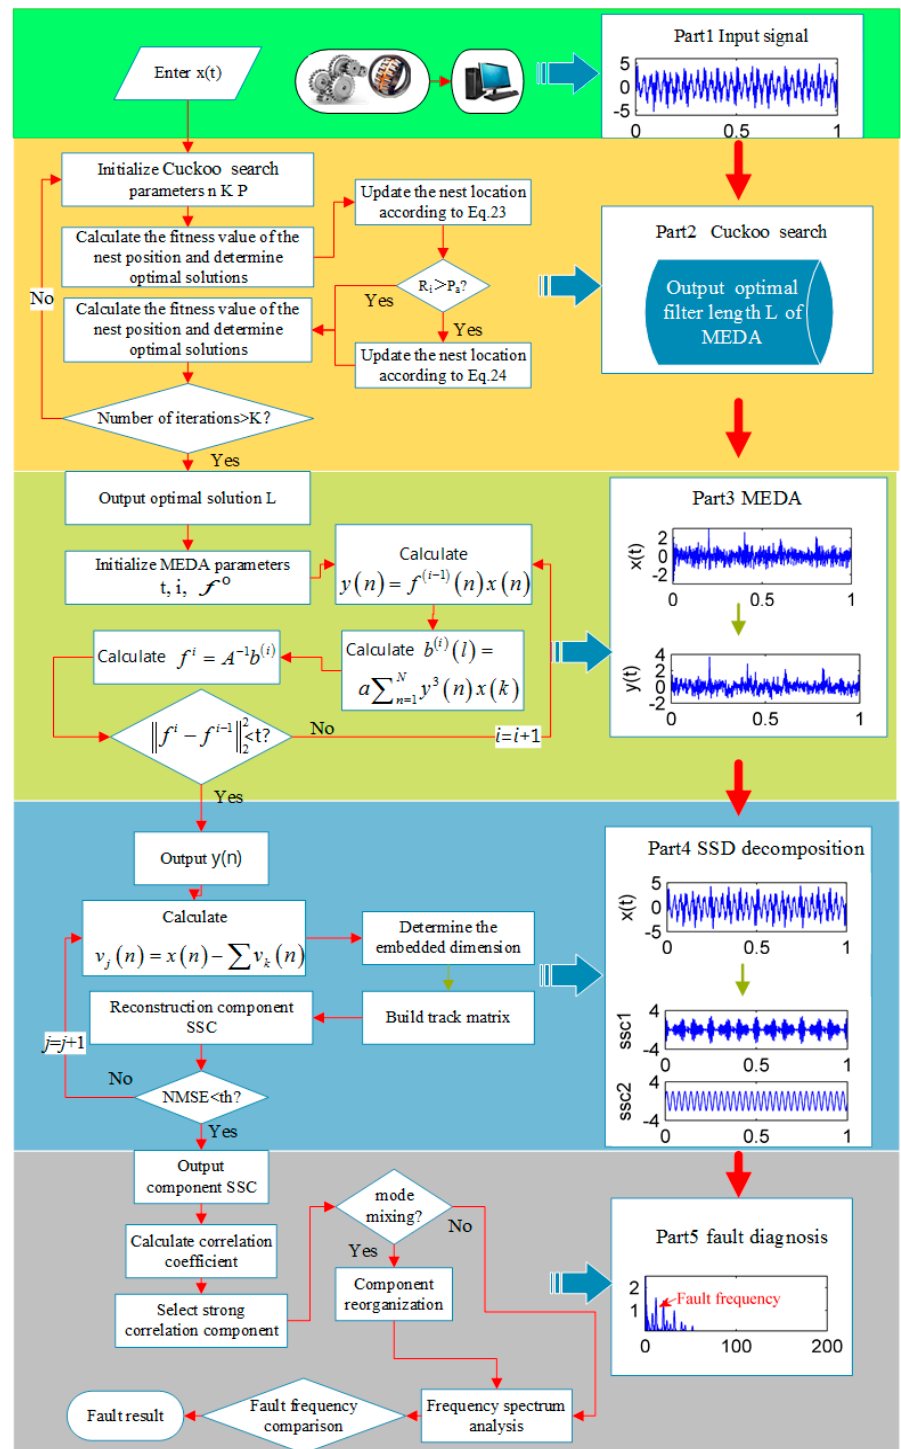
Figure 11. The flow chart of the improved singular spectrum decomposition.